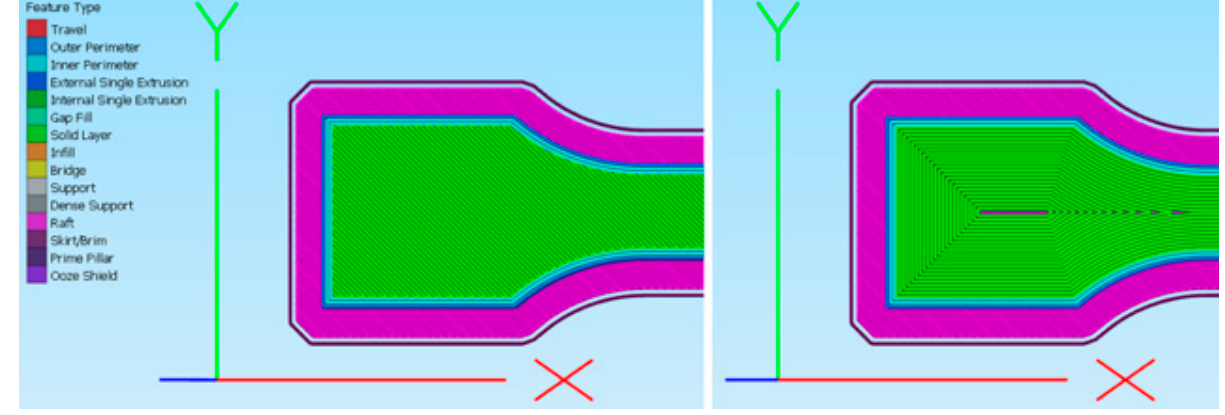
Figure 7. External Fill Pattern set to Rectilinear and Concentric.